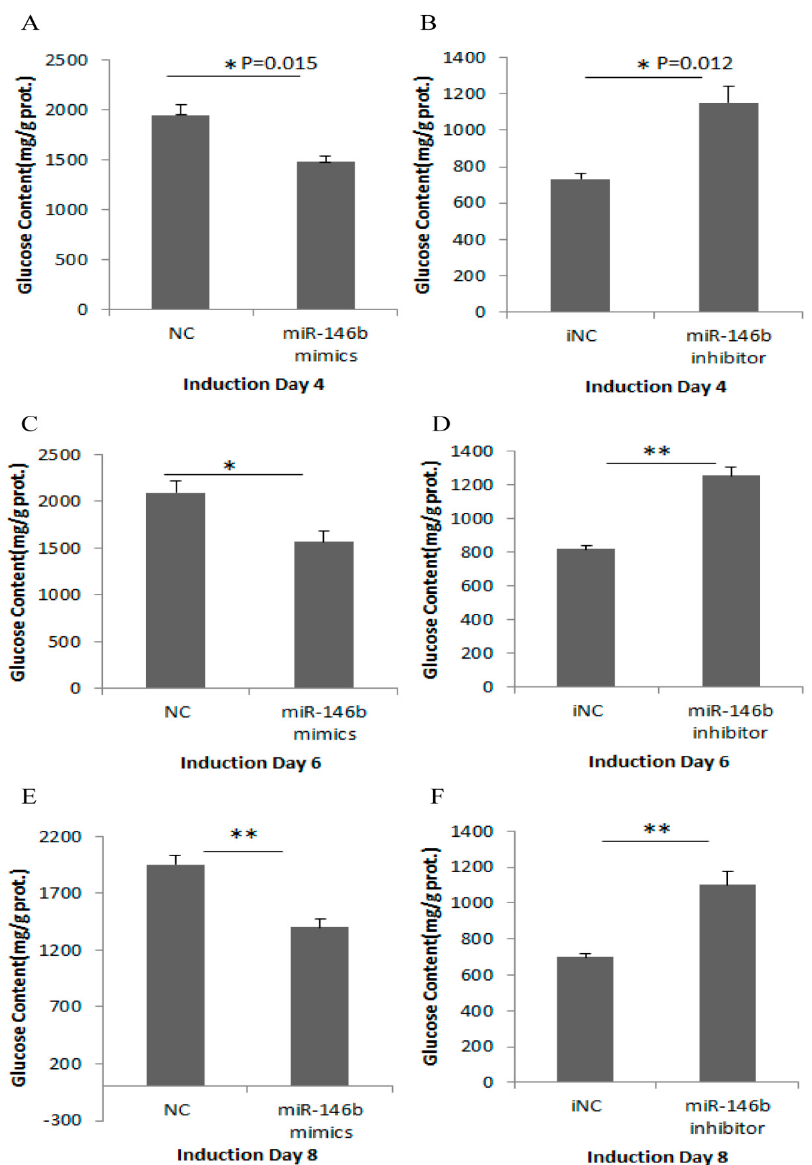
Figure 2. miR-146b inhibits the scavenging effects on glucose in porcine adipocytes. Note: Glucose consumption was determined after transfection of miR-146b mimics/NC or inhibitor/iNC. miR-146b mimics significantly reduced glucose clearance on day 4 ( A ); 6 ( C ) and 8 ( E ) respectively, while inhibitors exerted the opposite results ( B , D , F ). Data were presented as mean ± SD ( n = 6, * p < 0.05, ** p < 0.01).